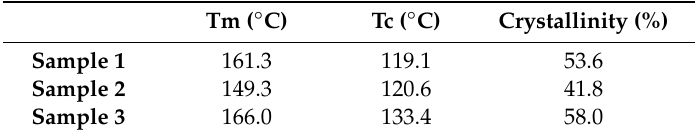
Table 4. Di ff erential scanning calorimetry (DSC) results, measured melting and crystallization temperatures, and calculated